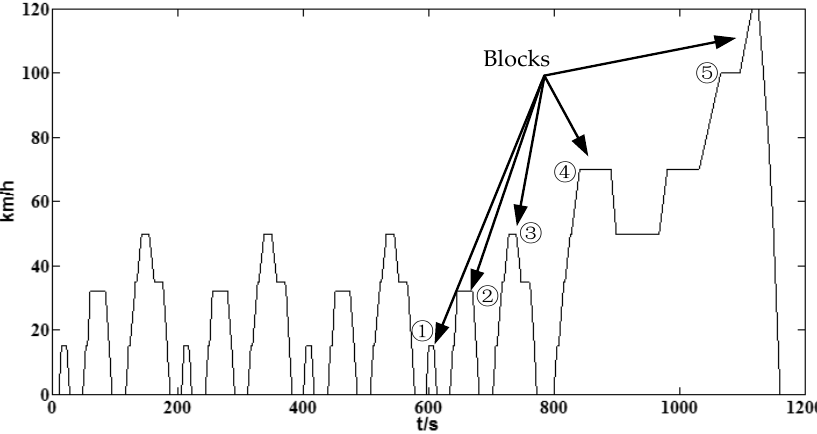
Figure 8. Division of “driving cycle blocks” in NEDC.